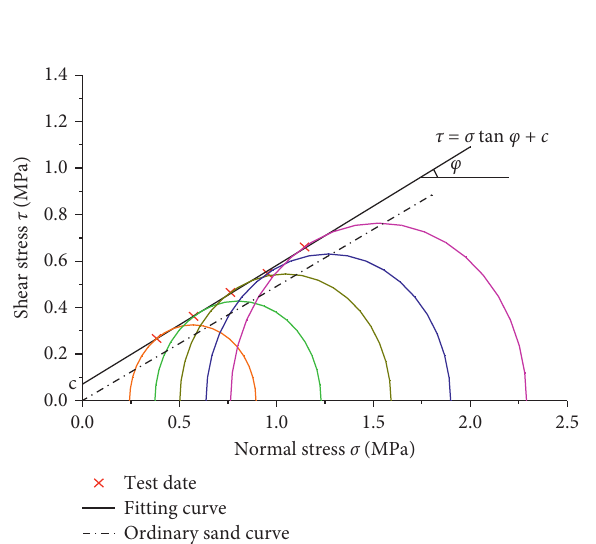
Figure 23: The strength envelope of